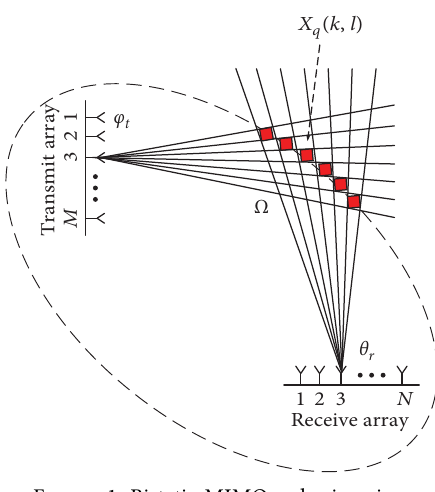
Figure 1: Bistatic MIMO radar